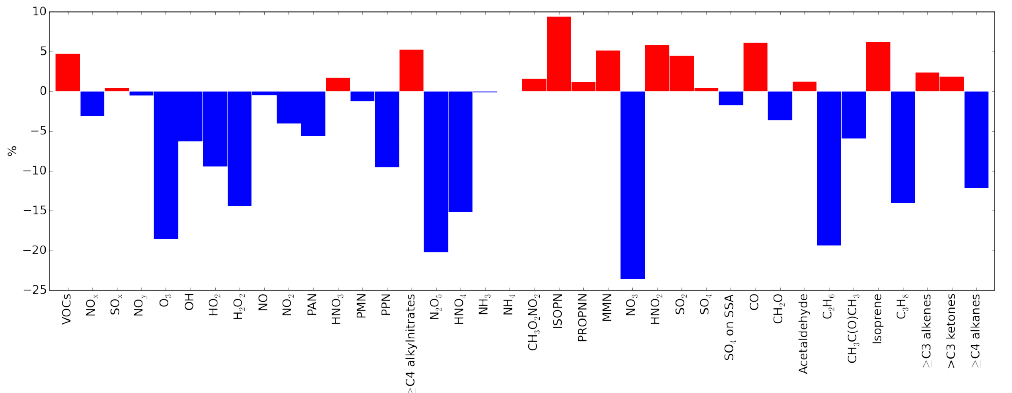
Figure 17. Changes in tropospheric burden of species and families on inclusion of halogens (“Cl + Br + I”) compared to no halogens (“NO- HAL”). Burdens are considered in elemental terms (e.g Tg S/N/C) and species masses for OH, HO 2 , H 2 O 2 , and O 3 . The family denoted by “VOCs” in this plot is defined as the sum of carbon masses of CO, formaldehyde, acetaldehyde, ethane, acetone, isoprene, propane, ≥ C4 alkanes, ≥ C3 alkenes, and ≥ C3 ketones. Abbreviations for tracers are expanded in Appendix